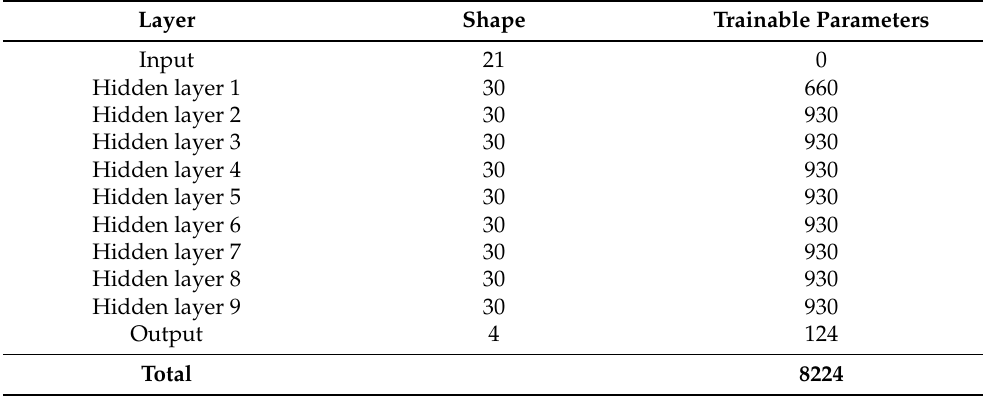
Table 8. The number of trainable parameters of the existing SRMT model [11]. Layer Shape Trainable Parameters Input